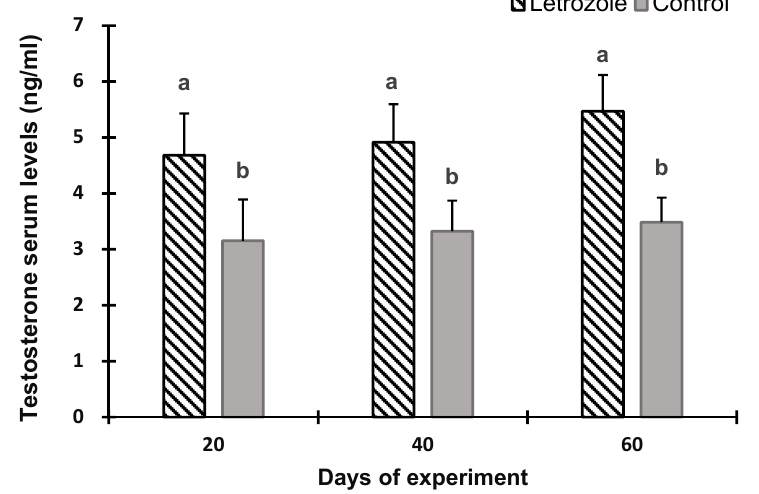
Figure 3. Testosterone levels in Markhoz bucks treated letrozole (0.25 mg/kg BW/wk) or control. Error bars indicate standard deviation. a,b Statistically significant differences (p<0.05) between the groups.